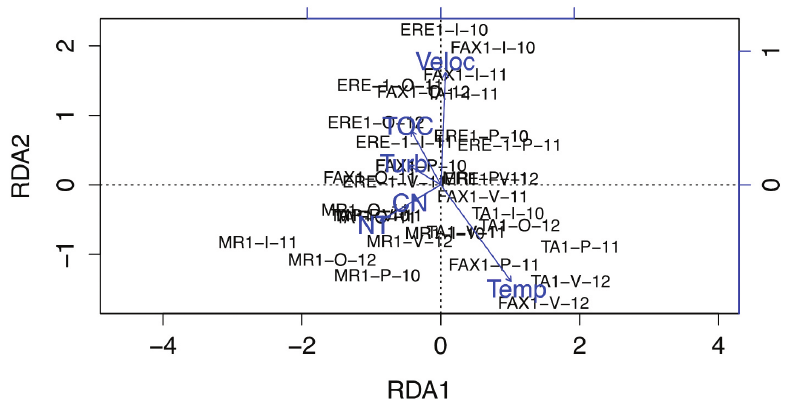
Figure 3. Redundance analysis with environmental variables and Chironomidae communities composition in the Alto Uruguai streams, Rio Grande do Sul, Brazil. ERE: Erechim; FAX: Faxinalzinho; TA: Três Arroios; MR: Marcelino Ramos; I: winter; V: summer; O: autumm; P: spring; 10, 11, 12: 2010, 2011, and 2012 years, respectivily. Veloc: current velocity; Turb: turbity; CN: carbon: nitrigen ratio; TOC: total organic carbon: TN: total